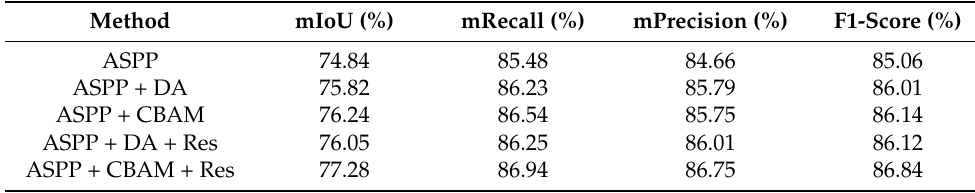
Table 3. Comparison of segmentation results using different ASPP